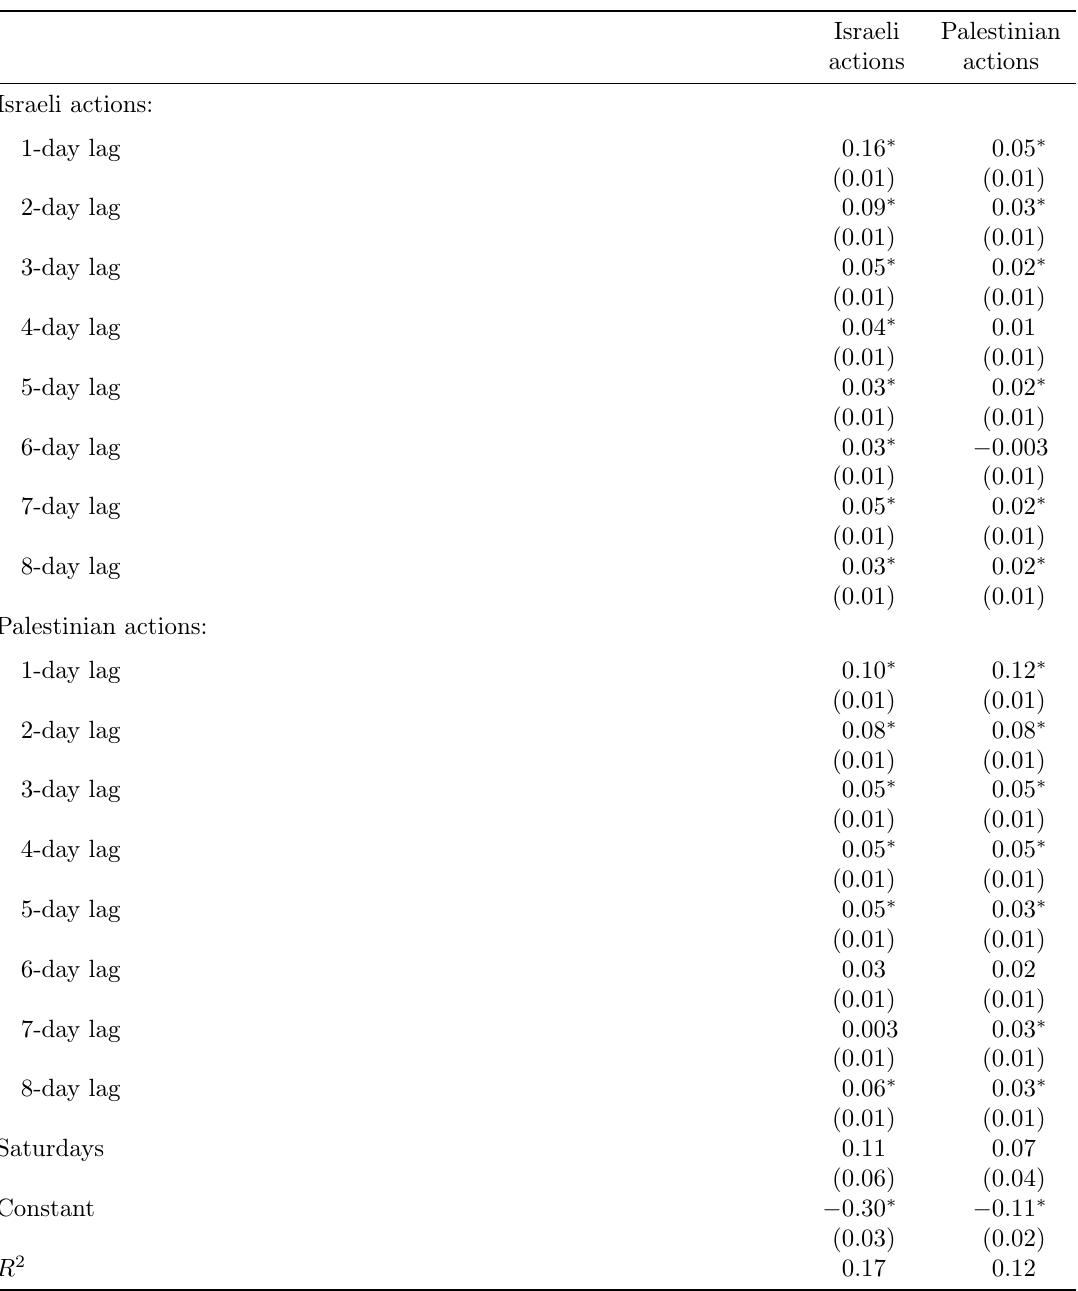
Table 2: Vector Autoregression